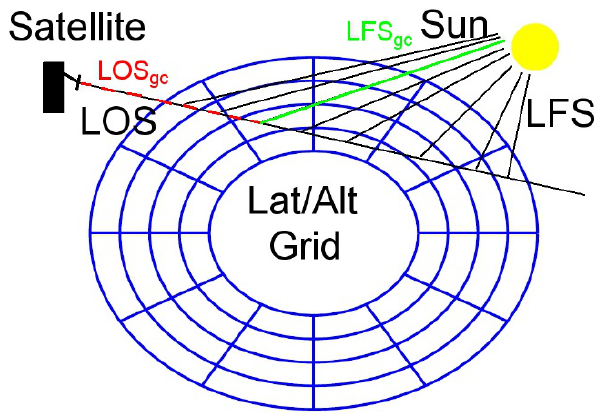
Fig. 13. Scheme of the altitude (radius) and latitude (sectors) grid and the line-of-sight (LOS) and line from Sun (LFS). Each grid el- ement may have a different LFS. Note that this figure shows only a specific 2-D projection of the atmosphere along a constant merid- ian so that latitude sectors are equally sized. Each grid cell on the LOS has its own matrices for the LFS from the Sun to the grid cell and the LOS from the grid cell to the satellite, which are needed for absorption